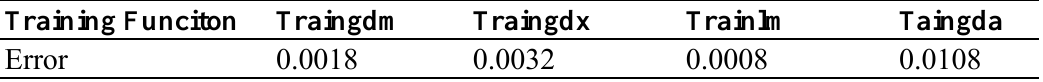
Table 1. The network error under different training function.